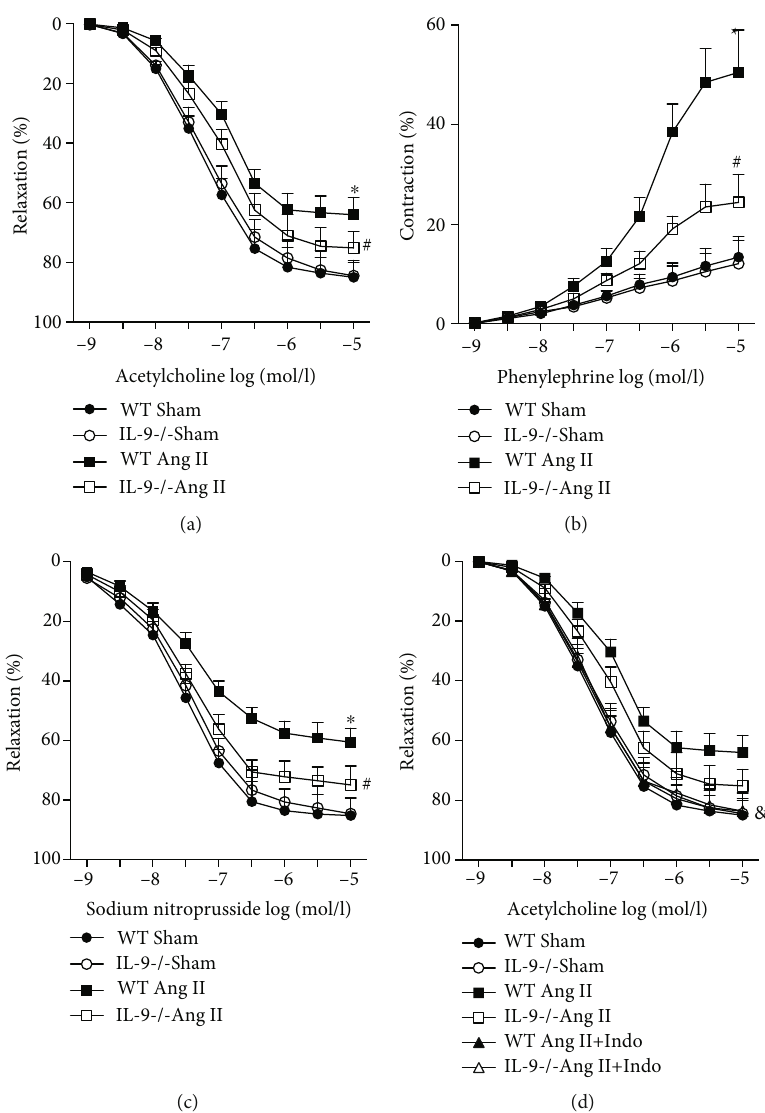
Figure 3: The regulatory e ff ect of IL-9 KO on vascular dysfunction. (a) The e ff ect of IL-9 KO on ACh-induced relaxation was measured in endothelial-intact aortas isolated from the four groups. (b) The e ff ect of IL-9 KO on PE-induced contraction was measured in endothelial- intact aortas isolated from each group. (c) The e ff ect of IL-9 KO on SNP-induced relaxation was measured in endothelial-intact aortas isolated from each group. (d) E ff ect of indomethacin on ACh-induced relaxation. N = 5 in each group. ∗ p < 0 : 05 vs. the WT Sham group; # p < 0 : 05 vs. the WT Ang II group; & p < 0 : 05 vs. the IL-9-/- Ang II